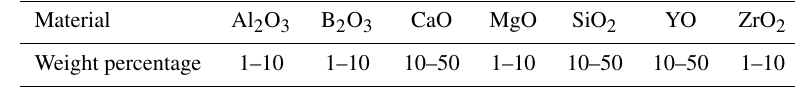
Table 3. Composition of the glass solder, G018-385, according to manufacturer’s specifications.